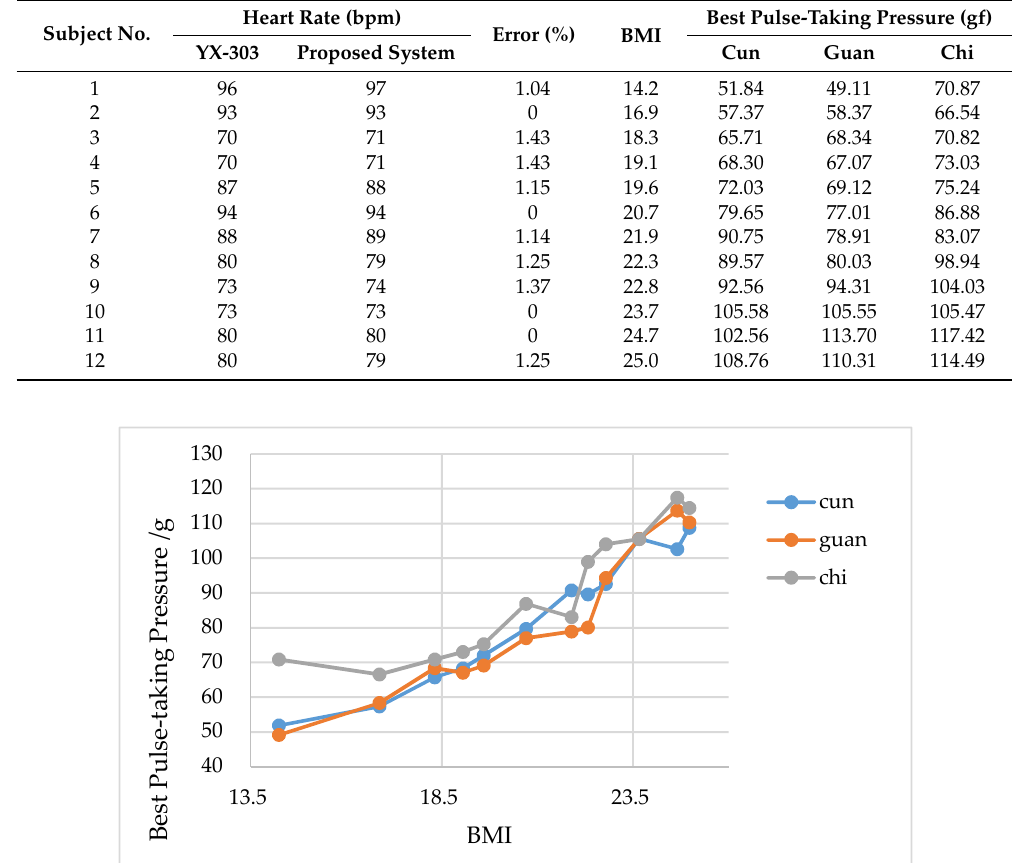
Figure 15. Trend of best pulse-taking pressure in three regions with body mass index (BMI).